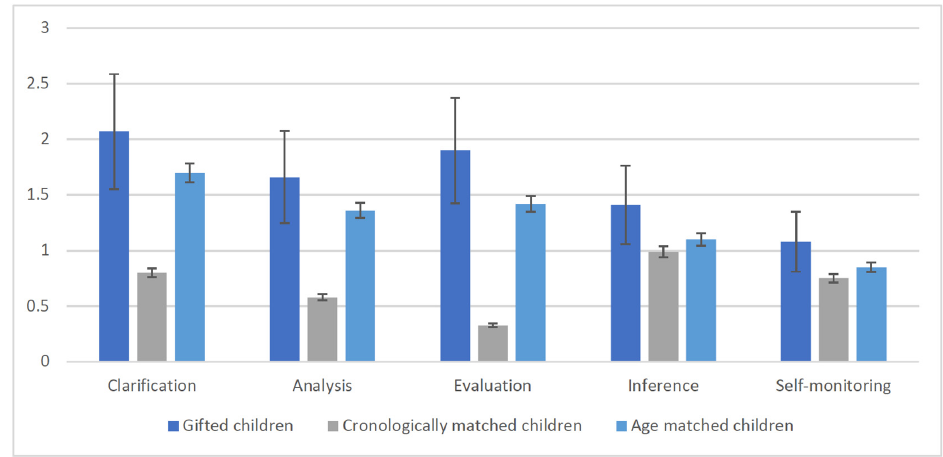
Figure 2. Means of the correct performance on the five phases of ethical critical thinking.